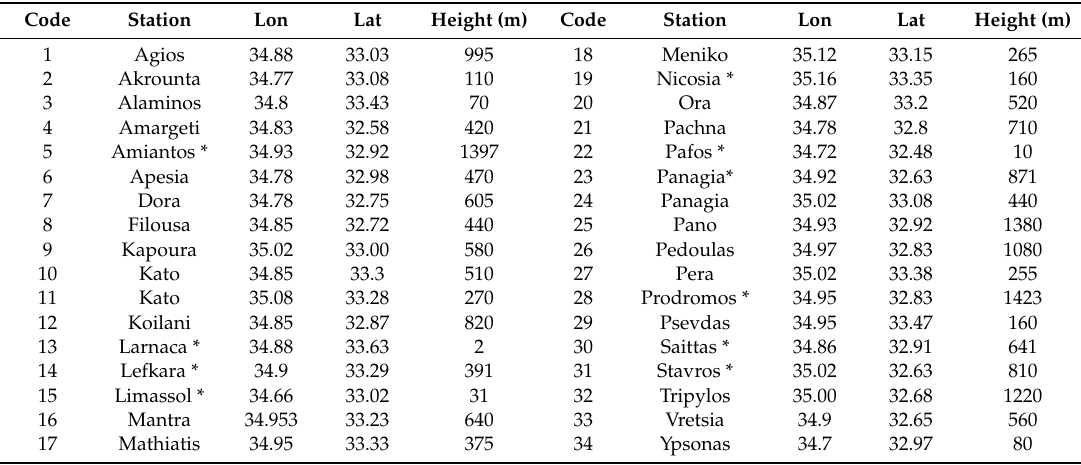
Table 1. Stations of the